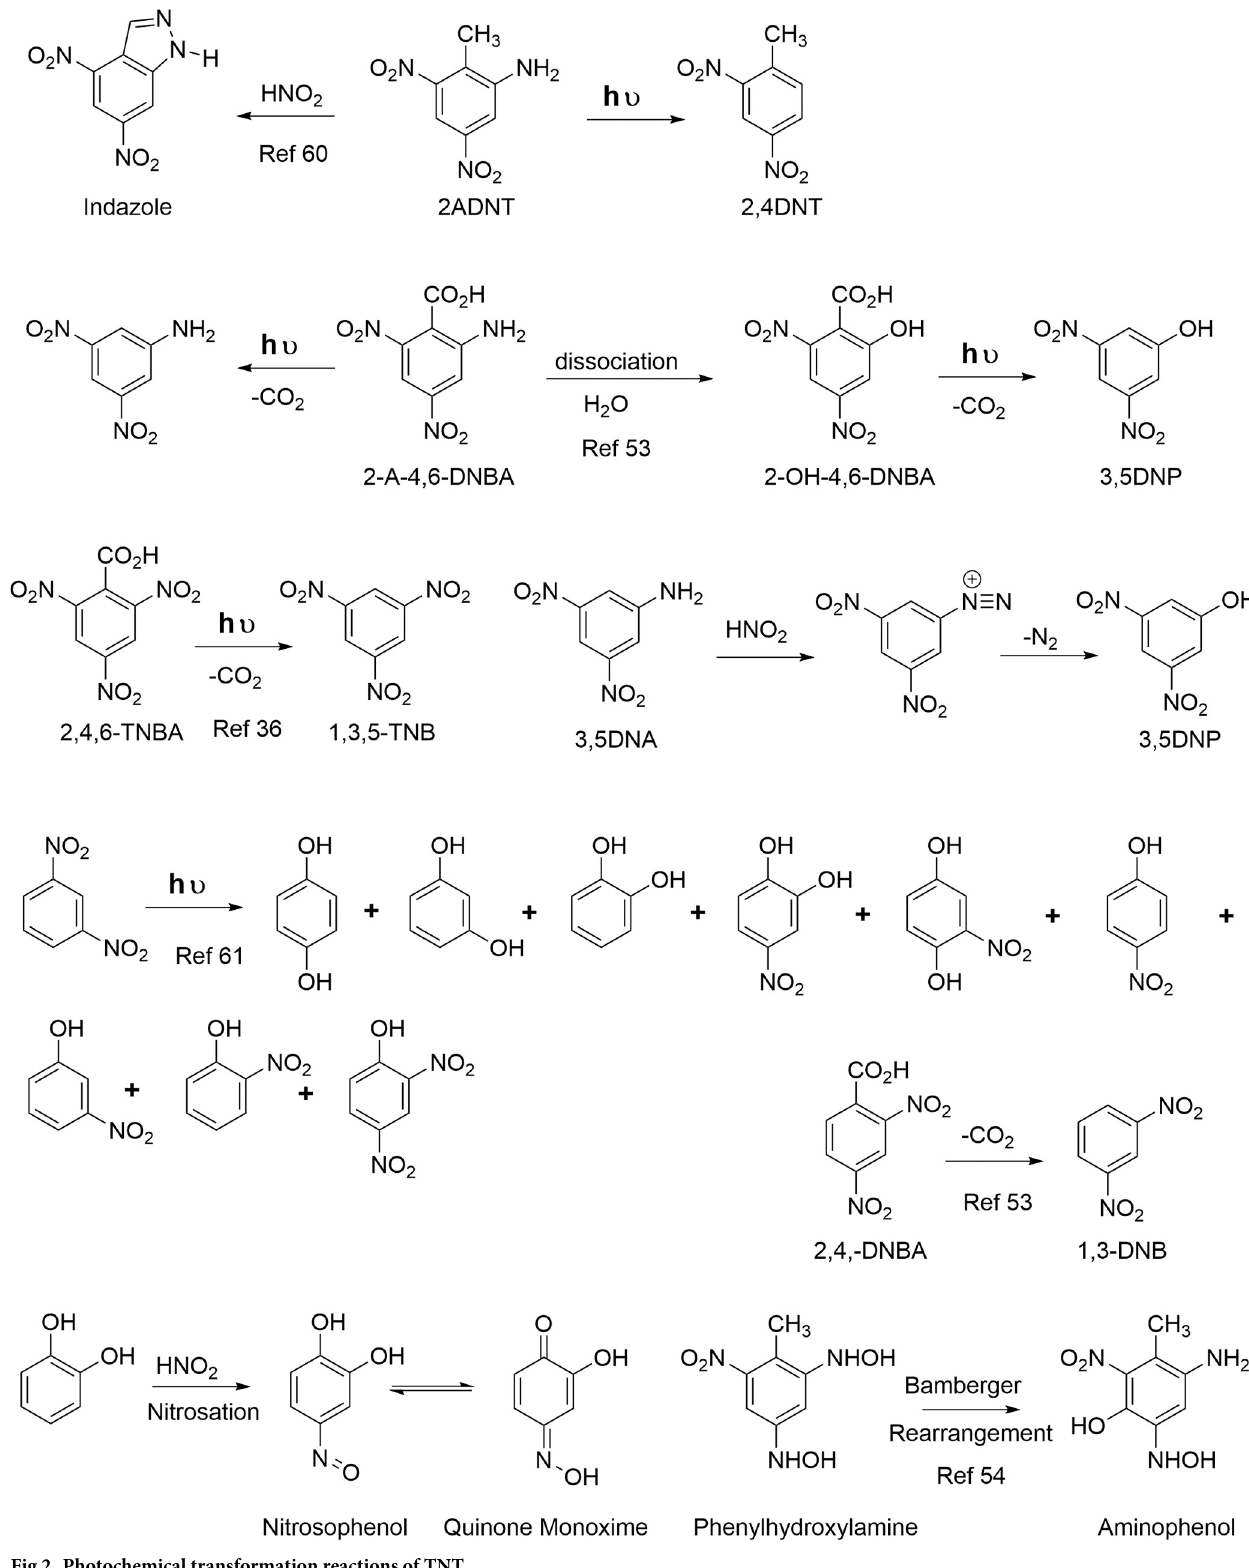
Fig 2. Photochemical transformation reactions of TNT.